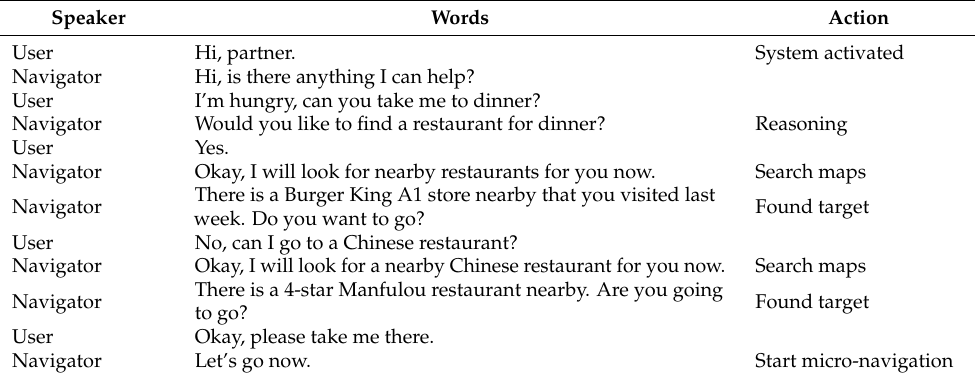
Table 3. Display of the dialogue process of the navigation system in the third